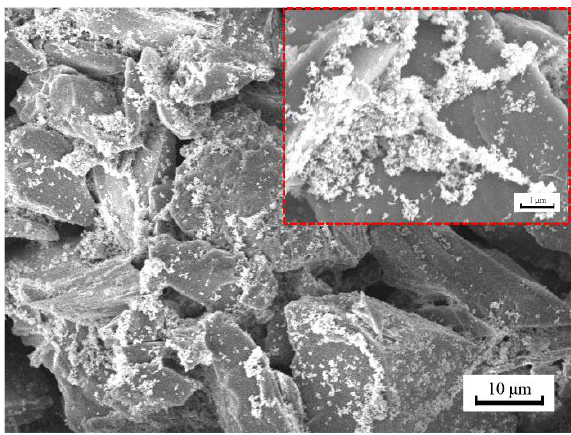
Figure 5. SEM image of superhydrophobic coating surface.